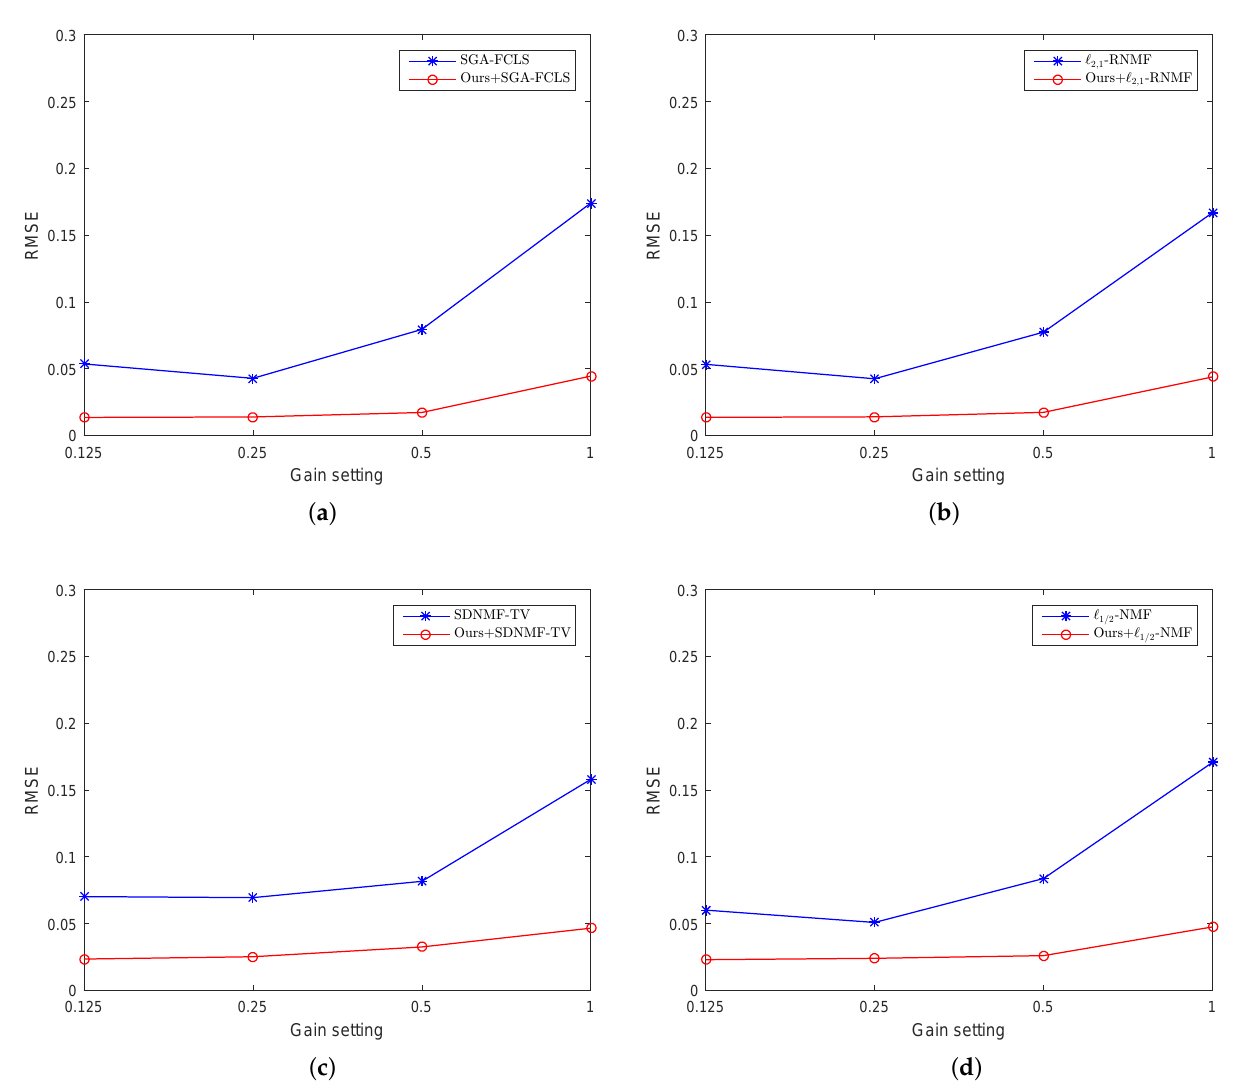
Figure 8. The RMSE results of unmixing algorithms with/without our proposed method under different gain settings. ( a ) SGA-FCLS. ( b ) (cid:96) 2,1 -RNMF. ( c ) SDNMF-TV. ( d ) (cid:96) 1/2